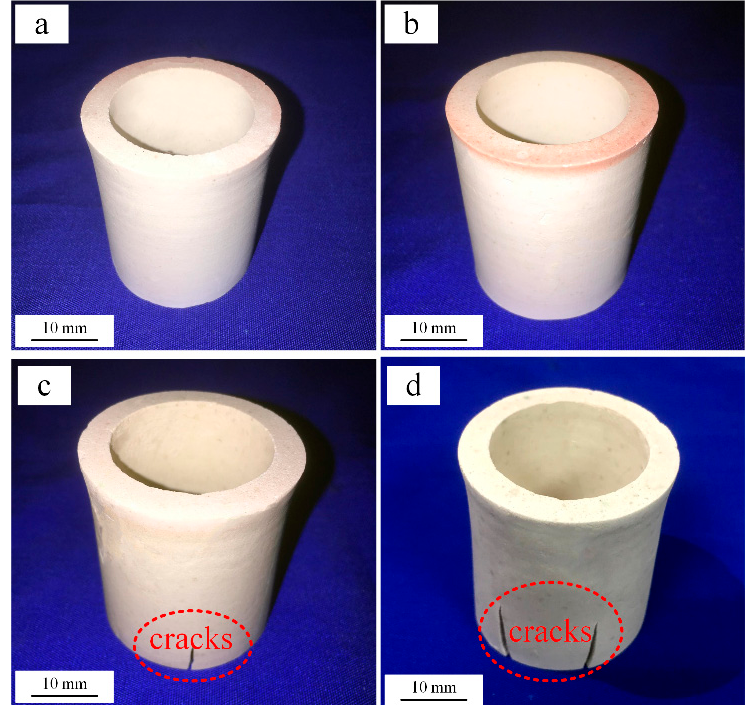
Figure 7. Images of CaO-based parts with different pre-sintering heating rates: ( a ) 0.5 °C/min, ( b ) 1.0 °C/min, ( c ) 1.5 °C/min, and ( d ) 2.0 °C/min.